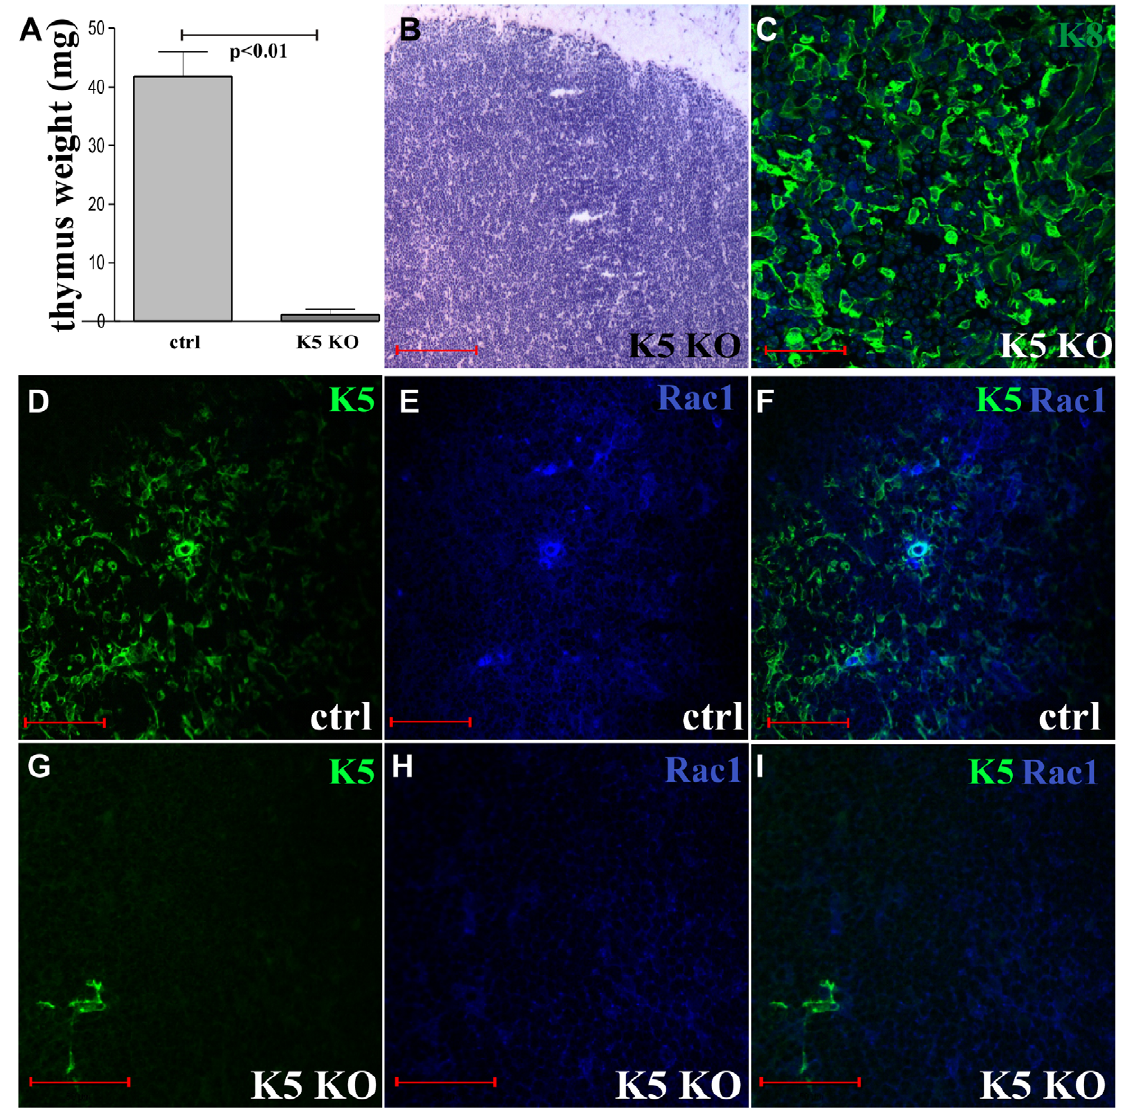
Figure 4. Effects of embryonic Rac1 deletion on thymus ontogeny. (A) Reduced weight of K5CrexRac1 flox/flox (K5 KO) thymus compared to Cre negative litter mate controls (ctrl) (error bars are Standard Errors). (B and C) Destruction of distinct medullary/cortical boundaries in K5CrexRac1 flox/flox mice (K5-KO) (B) leaving predominantly K8 positive cortex (C). (D–I) Cre negative littermates (ctrl, D–F) have normal Rac1 and K5 expression compared to reduced expression in K5CrexRac1 flox/flox (K5-KO) mice (G–I). (B) 6 10 and (C) 6 20. Scale bars 50 m